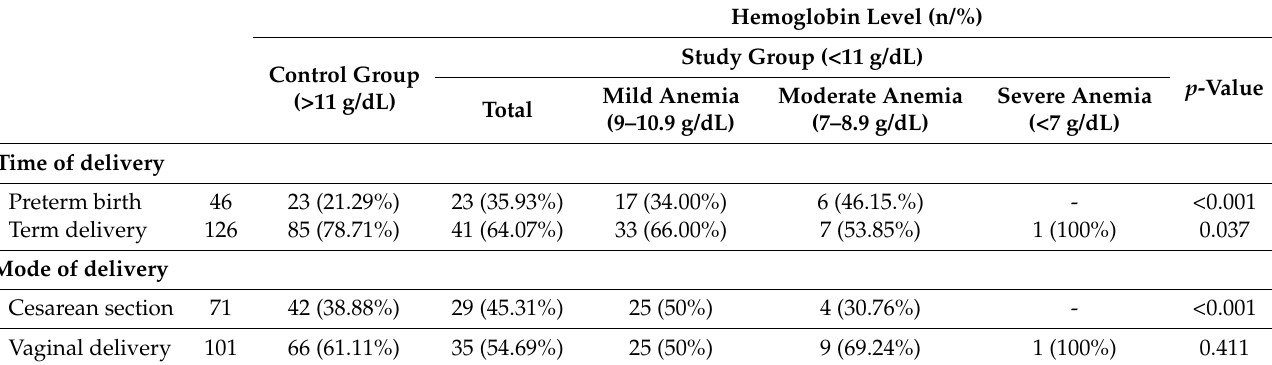
Table 3. Distribution of patients according to the time and mode of